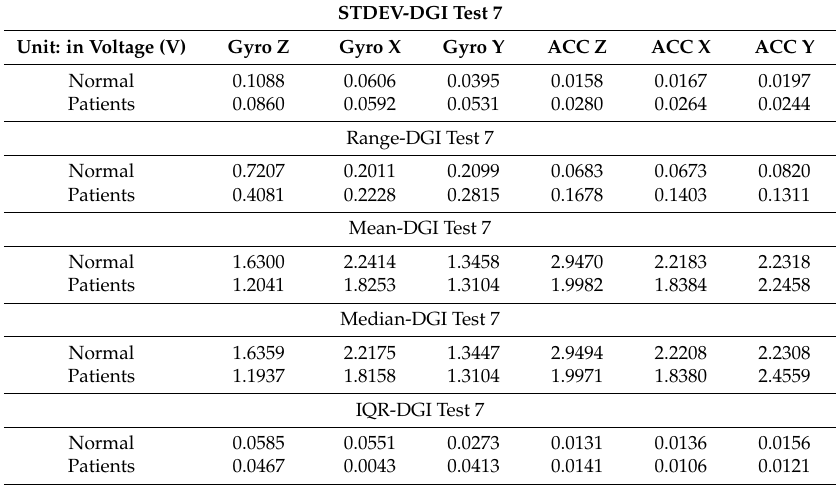
Table 3. The STDEV, range, mean, median and IQR of DGI Test 7 data averaged for all normal subjects vs.